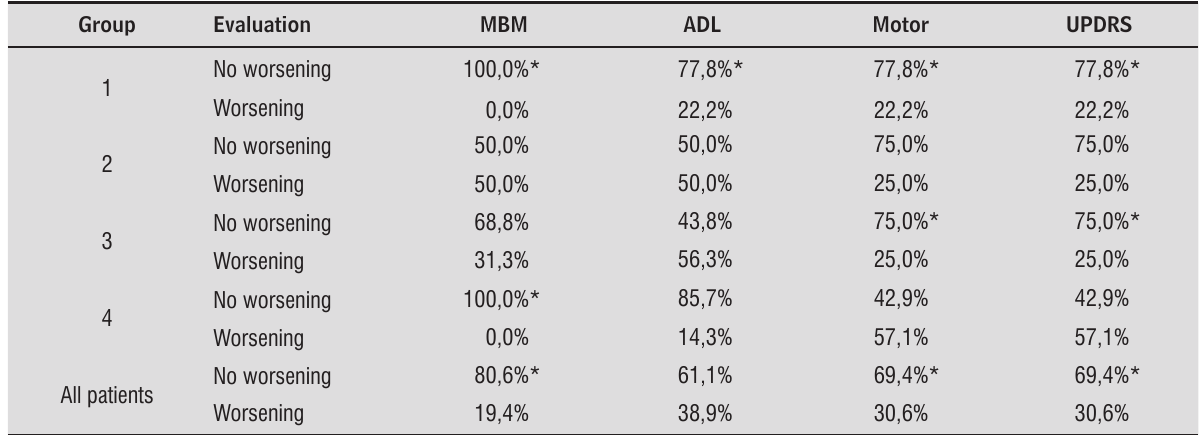
Table 3 - Worsening and no worsening evaluation assessment on the home-based physiotherapy program